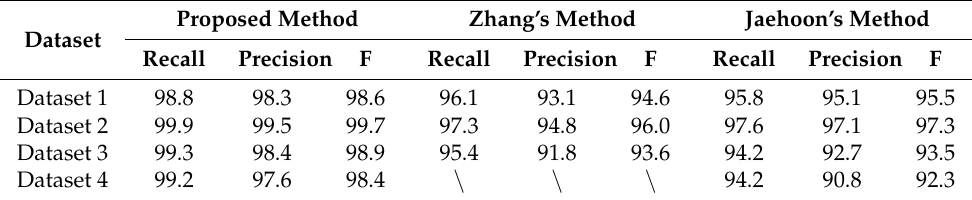
Table 8. The accuracy performance comparison among the existing approaches (unit: %).